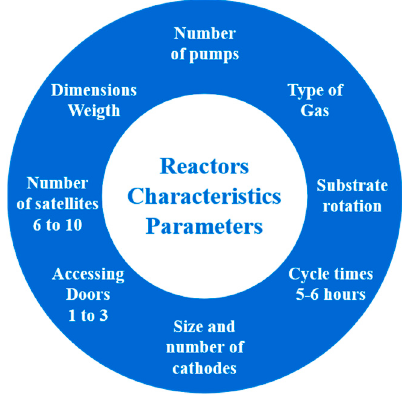
Figure 5. Characteristics and parameters chambers.